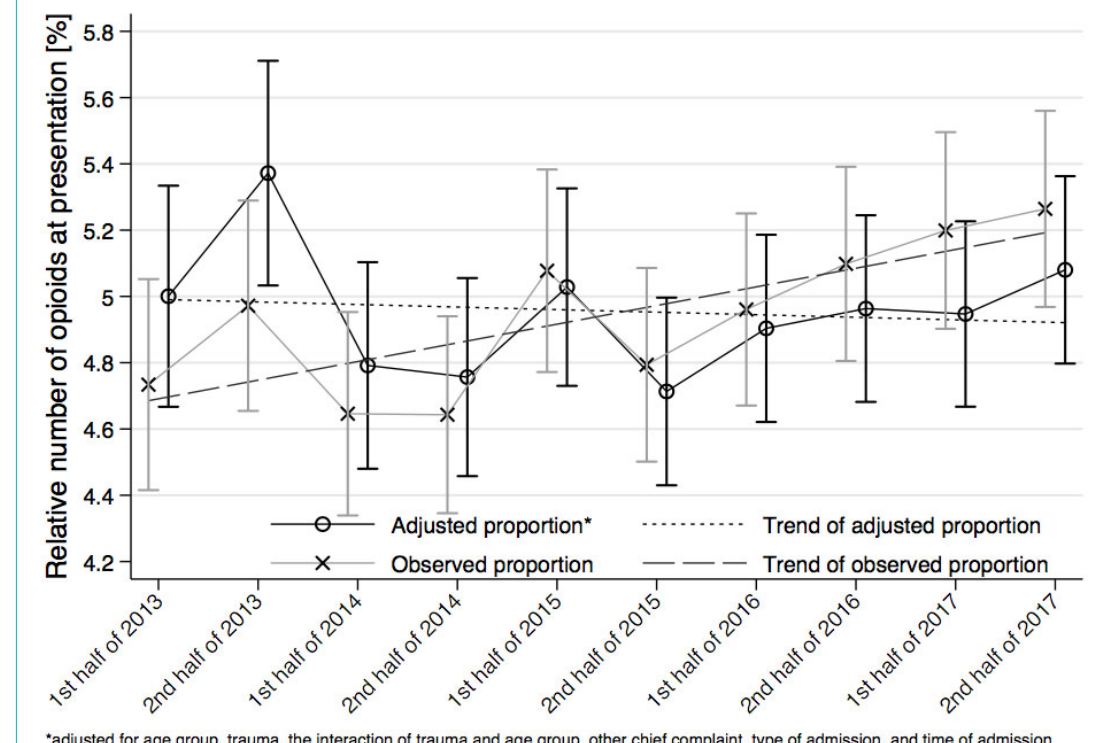
Figure 3: Observed and adjusted relative number of opioid use on presentation (prevalent opioid use) including a linear trend. The relative number per six months with accompanying 95% confidence interval are presented, n =